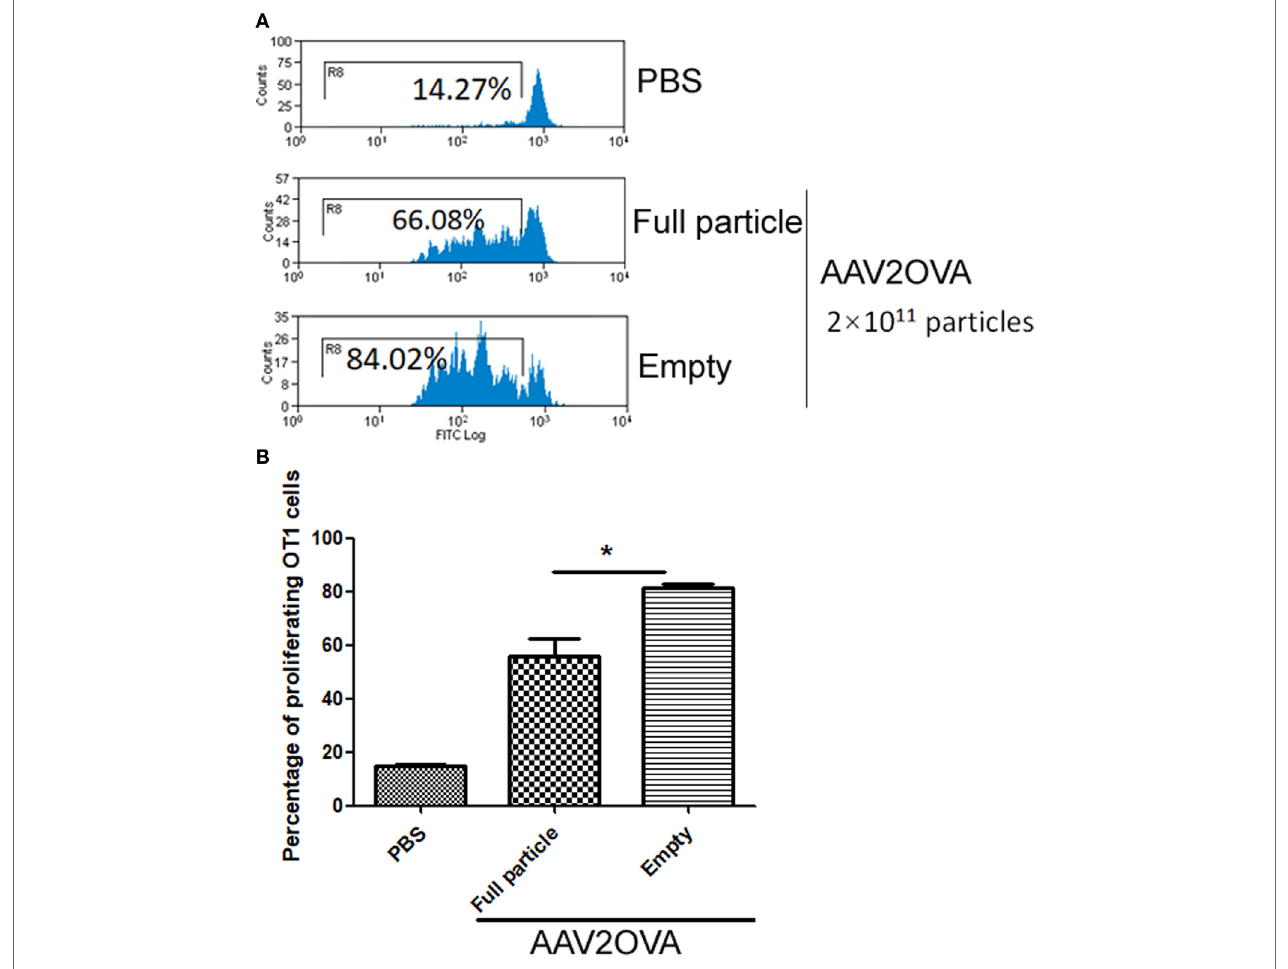
FigUre 1 | Efficient capsid antigen presentation from systemic administration of AAV2OVA empty virions in mice. 2 × 10 11 particles of AAV2OVA empty virions or full particle vectors encoding transgene alpha-1-antitrypsin were intravenously injected into C57BL/6 mice via retro-orbital vein. At day 3 post adeno-associated virus (AAV) injection, 5 × 10 6 CFSE-labeled OT-1 T cells were transferred into the mice. Ten days after transfer of OT-1 cells, the proliferation of OT-1 T cells was measured by flow cytometry. (a) Representative flow cytometric histograms. (B) Average T cell proliferation and SD for four mice. * p < 0.05 compared to mice with AAV full particle